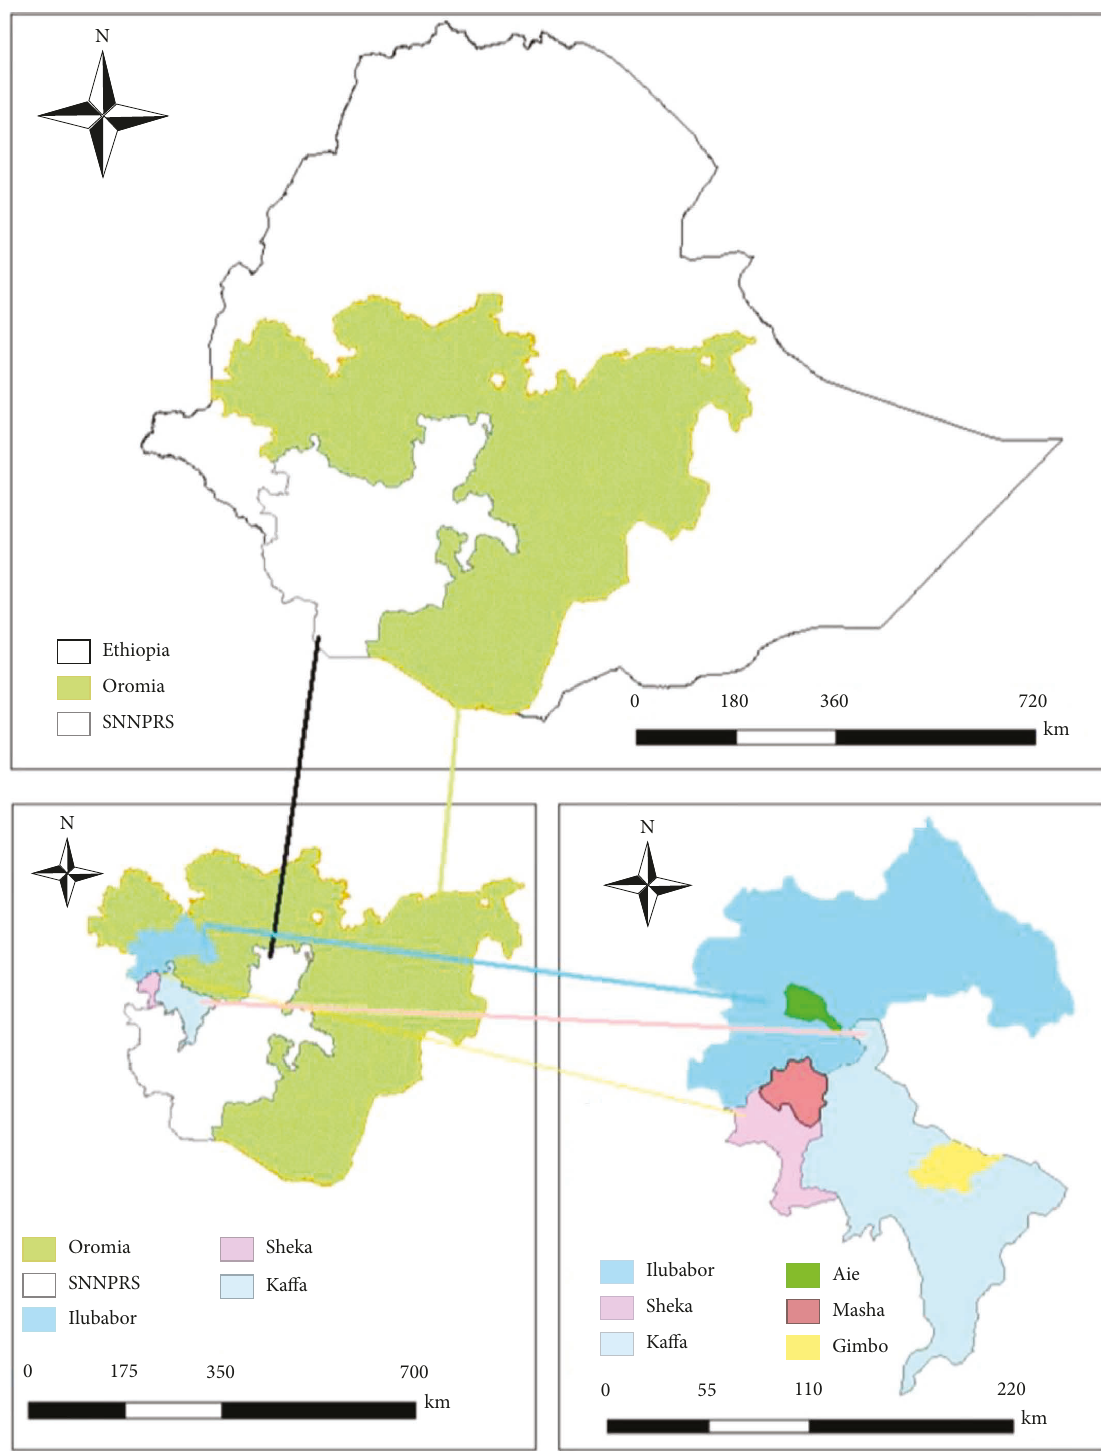
Figure 1: Map of Ethiopia showing regions, zones, and districts of Southwest Ethiopia known for tea production